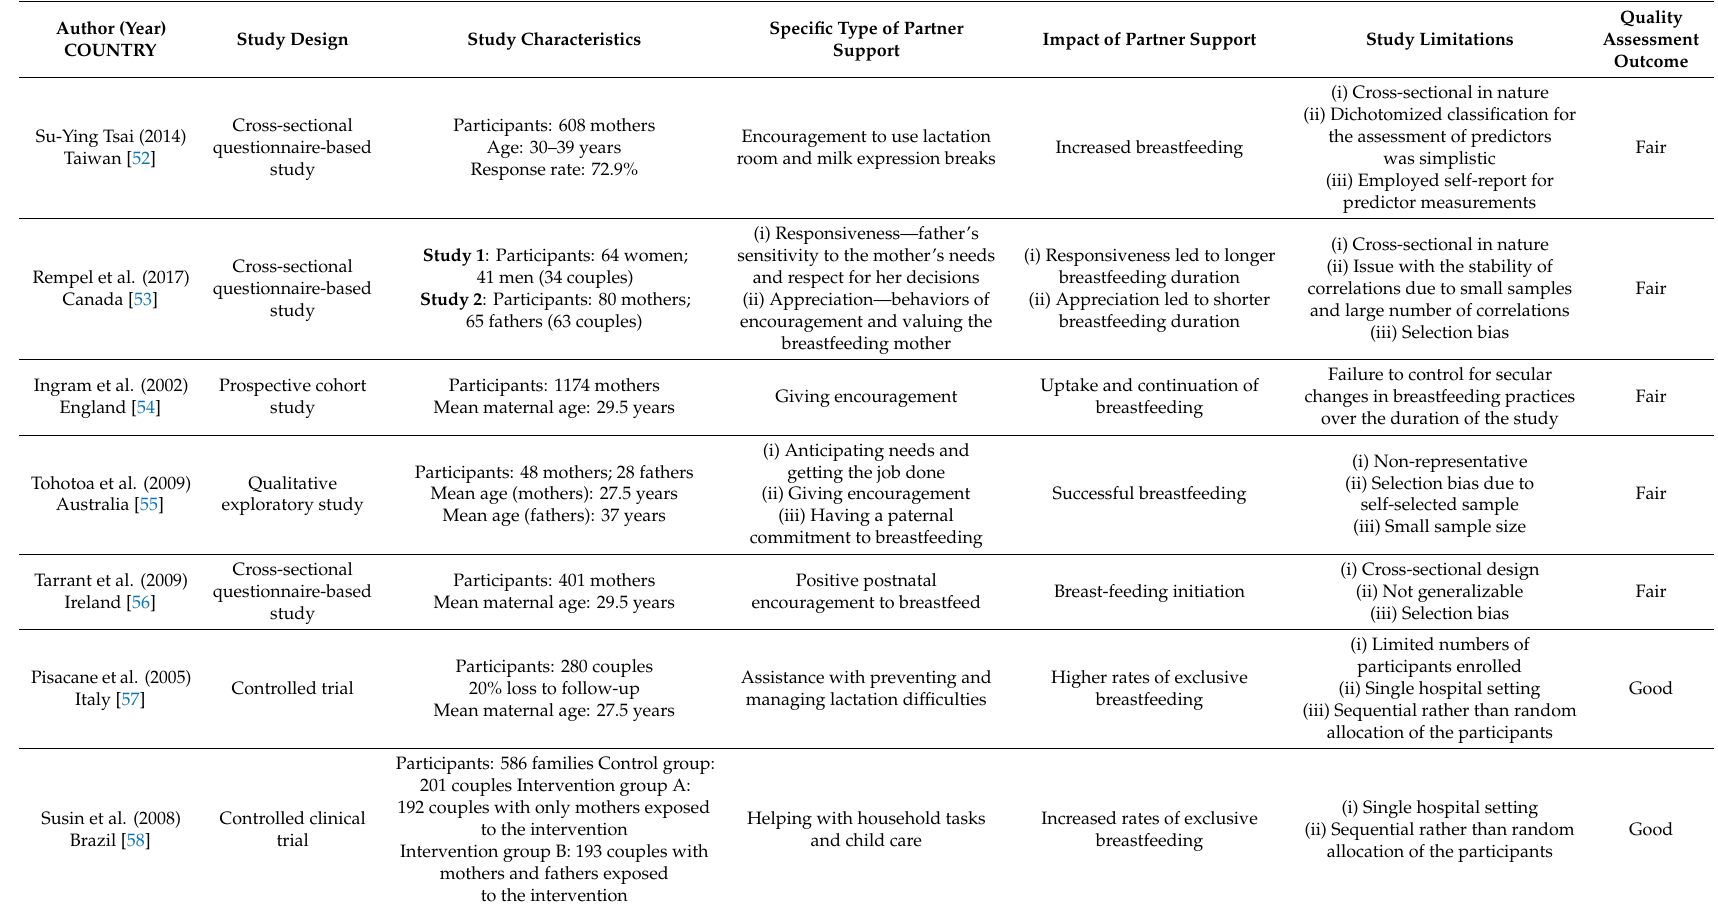
Table 1. Summary of selected